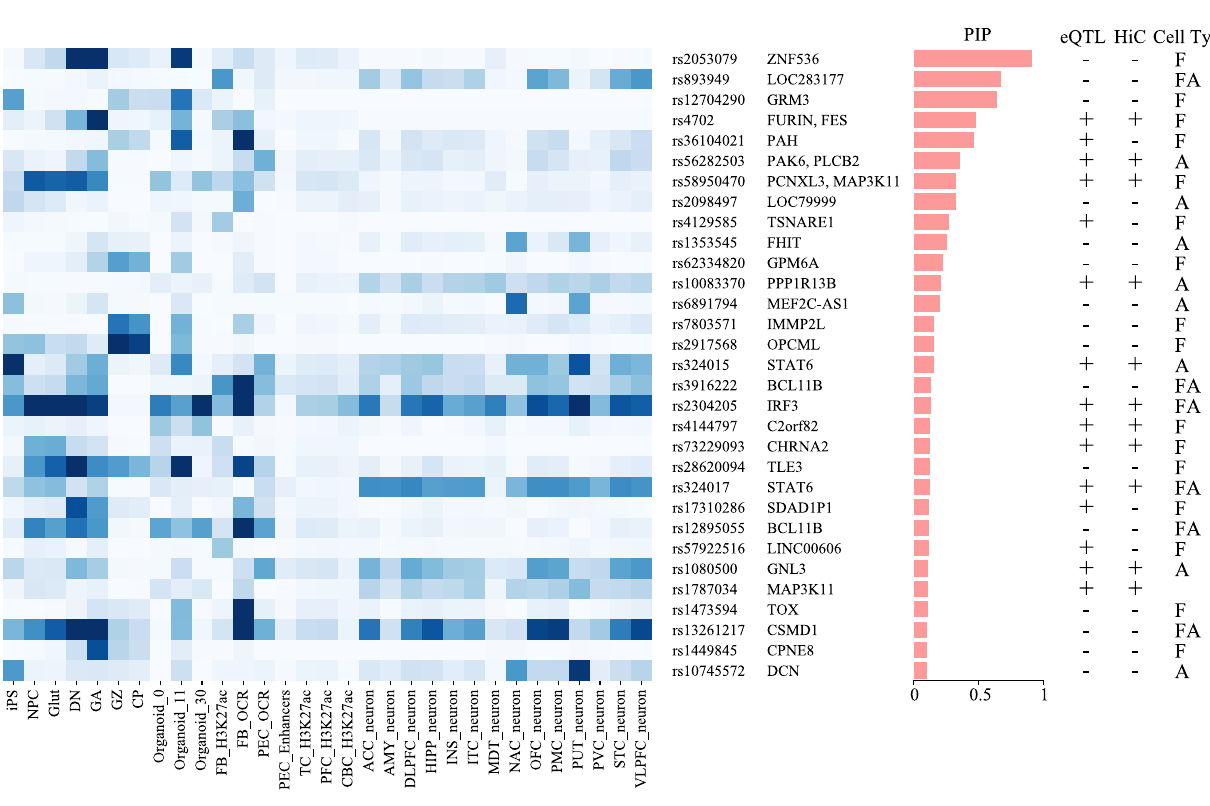
Fig 5. MetaChrom score of 31 candidate SNPs across 31 cell types. Candidate SNPs are ordered by their posterior inclusion probability (PIP) values shown in the middle. Three columns on the right indicate if a SNP is an eQTL (+/-), if a SNP has HiC targets (+/-) and if a SNP acts mostly in fetal stage (F) or in adult stage (A) or both